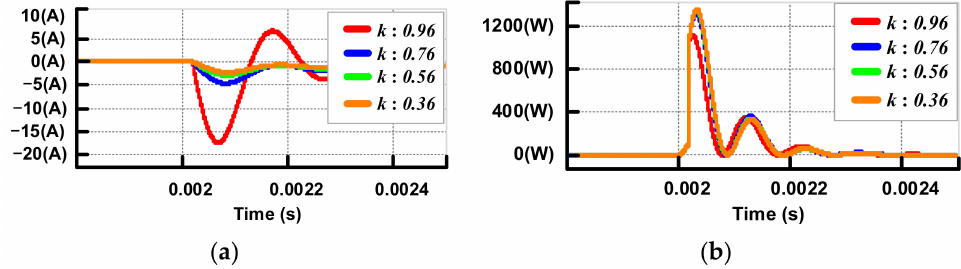
Figure 7. Simulation waveforms for different coupling coefficients: ( a ) current in secondary winding and ( b ) power burden of parallel resistor linked to secondary